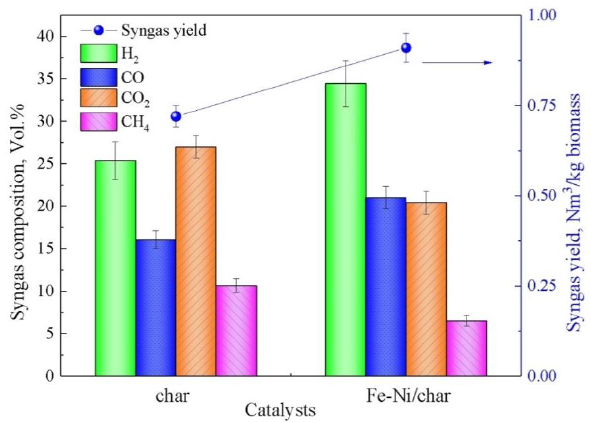
Figure 3. Syngas yield and composition with different catalysts.